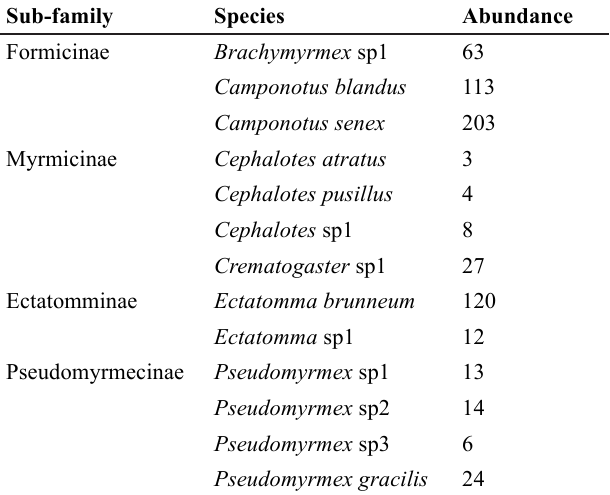
Table 1 . List of ant species found in Tocoyena formosa plants with the total number of observed individuals.